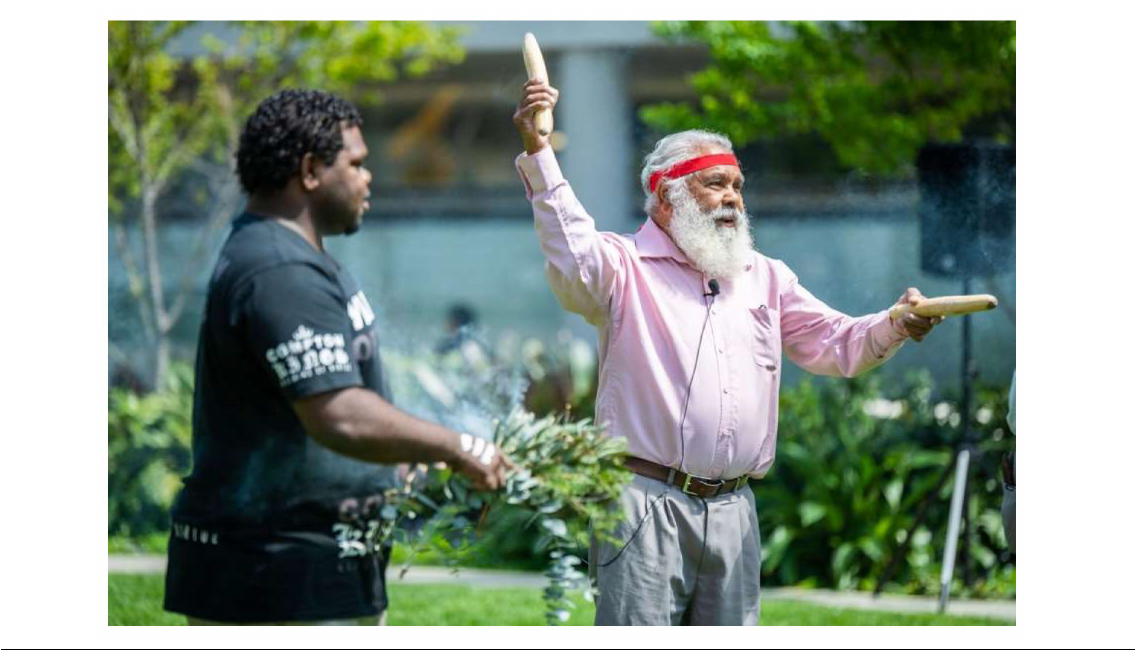
Figure 3. Uncle Max and Scott McDinny (Source: photograph by Kwa